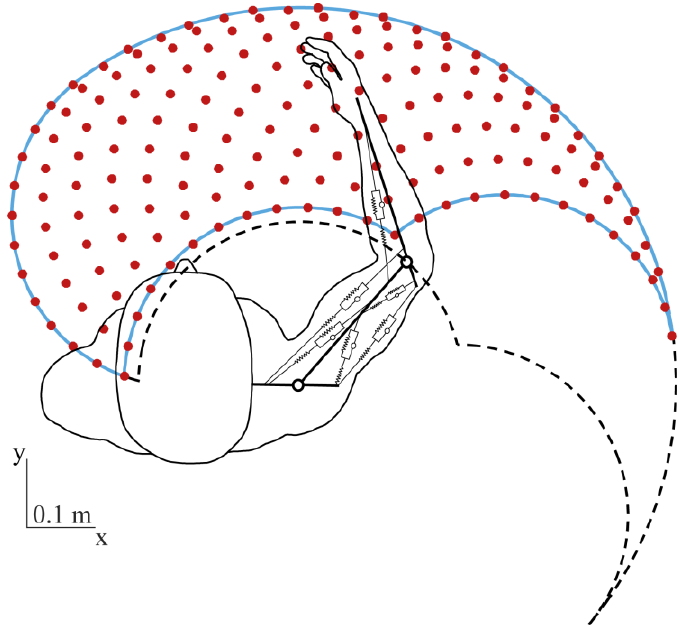
Figure 4. Workspace of the upper-limb model. The physiological workspace (black dashed line) and the workspace of the model (blue continuous line) are plotted. The positions in which the endpoint stiffness was calculated are indicated by red circles.